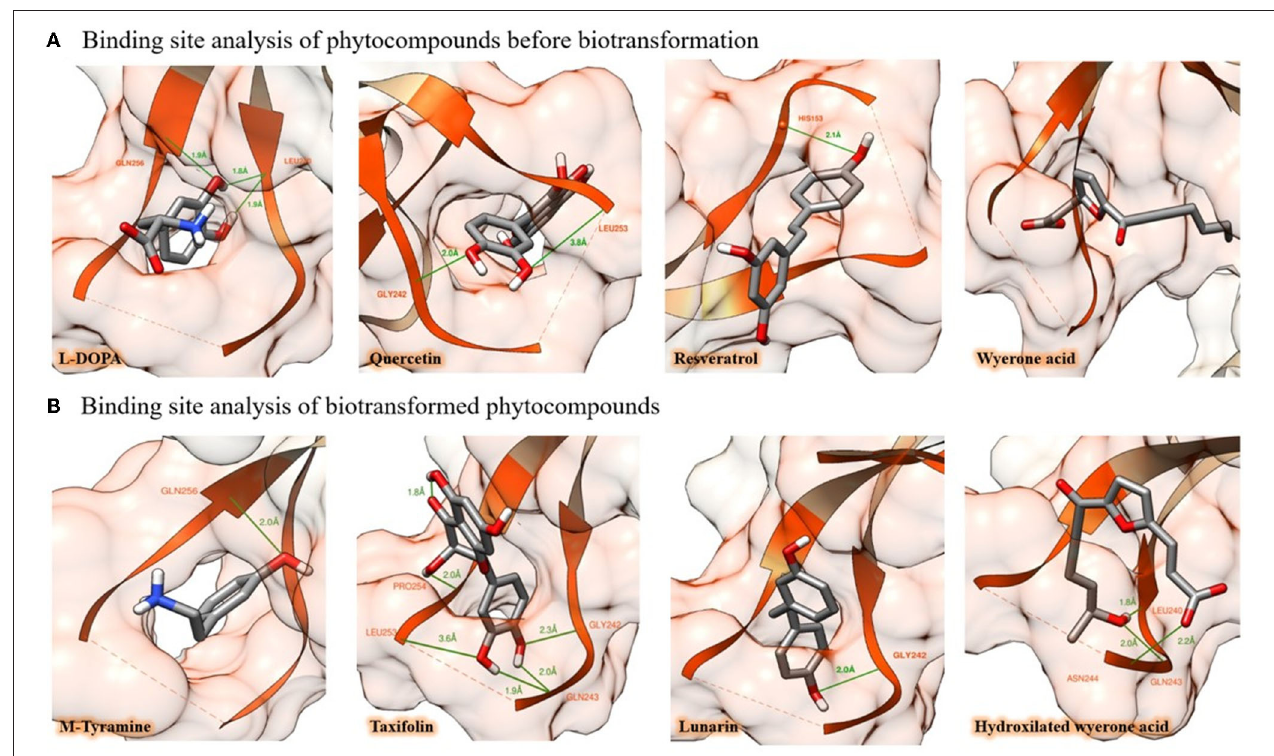
FIGURE 1 | In silico binding potential of some natural products in broad beans against the PAS-A domain of the AhR. (A) Putative binding mode of L-DOPA, quercetin, resveratrol, and wyerone acid, to AhR protein, amino acid residues are highlighted in orange, whereas H-bond interactions of molecules are depicted with green lines. (B) After being biotransformed by enterocytes or microbiome, the natural products undergo chemical modifications that improve their binding capacity. In this figure, this process is illustrated by showing four events of biotransformation that resulted in enhanced AhR-binding affinity (the simulations of the 30 molecules, their figures, and binding energy before and after their biotransformation are provided in the Supplementary Material